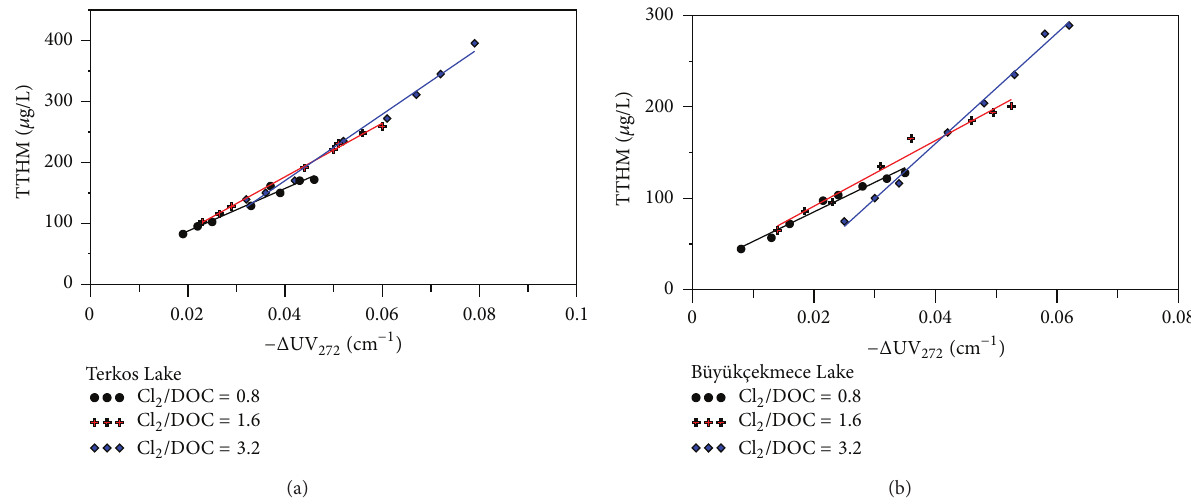
Figure 3: Correlations between Δ UV 272 values and TTHM concentrations at different Cl 2 to DOC ratios, pH 7, and reaction times from 1h to seven days for (a) TL water and (b) BL water samples.